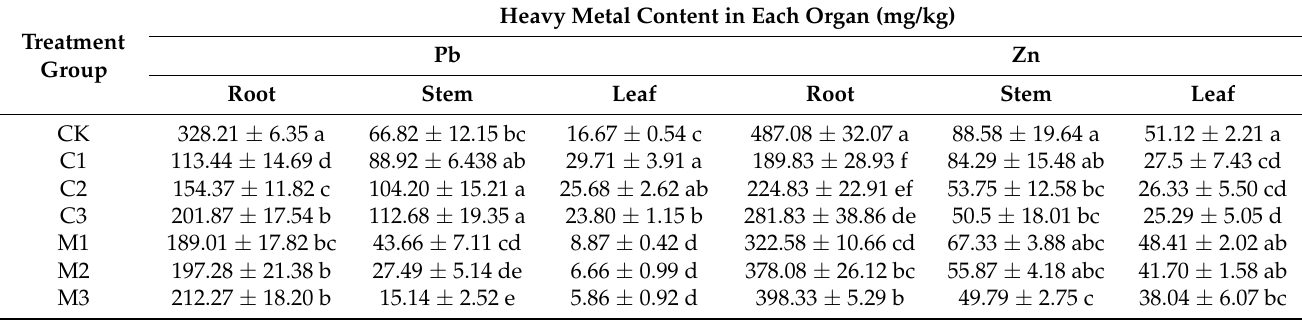
Table 4. Heavy metal content in different organs of Nerium indicum